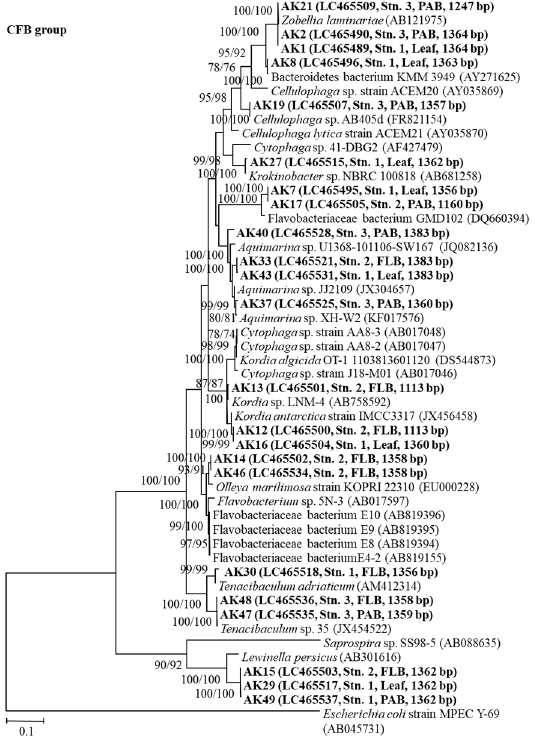
Figure 12. Phylogenetic tree for the CFB group of 16S rRNA gene sequences (~1300 bp). See the Figure 11 legend for the explanation of the tree. The outgroup is Escherichia coli .